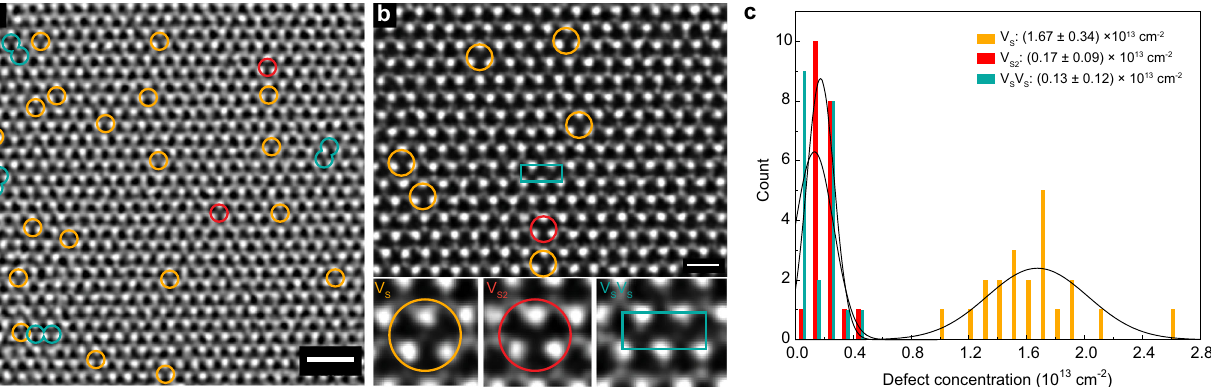
Fig. 4 | Atomic defects characterized by scanning transmission electron microscope (STEM). a , b Filtered STEM image showing different types of defects. Orangeandredcircleshighlightsingle(V S )anddouble(V S2 )sulfurvacancydefects, respectively, while the turquoise green box marks two V S right next to each other